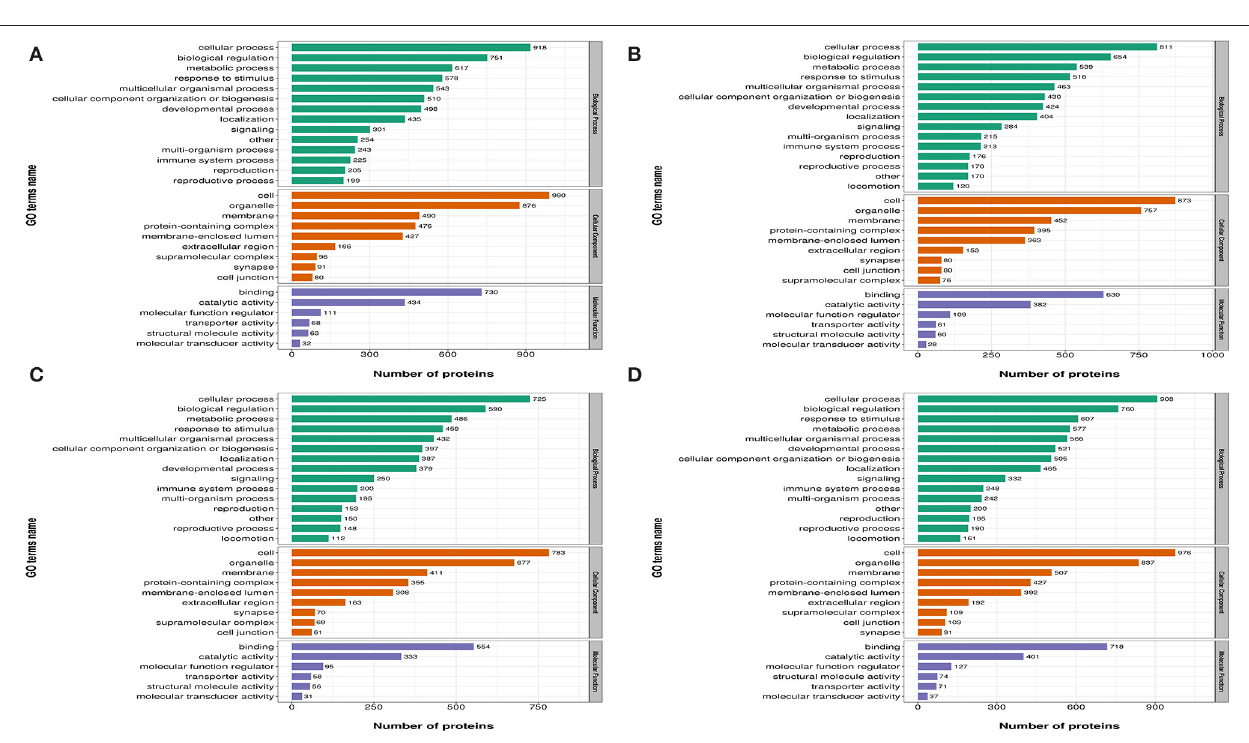
protein-coupled serotonin receptor binding, and proteasome- activating ATPase activities. At 28 dpi, proteins were mainly concentrated in actin binding, enzyme activity, and extracellular matrix structural